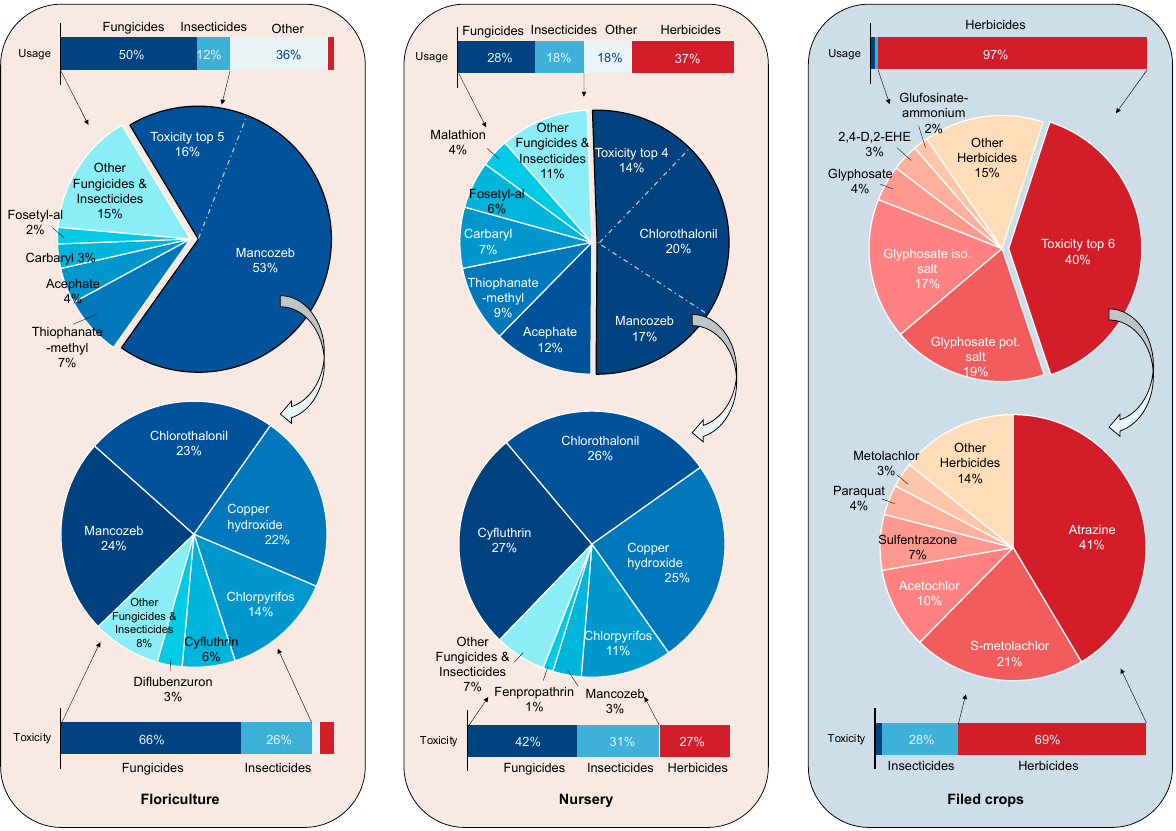
Figure 3. Pesticides usage and ecotoxicity variation analysis.